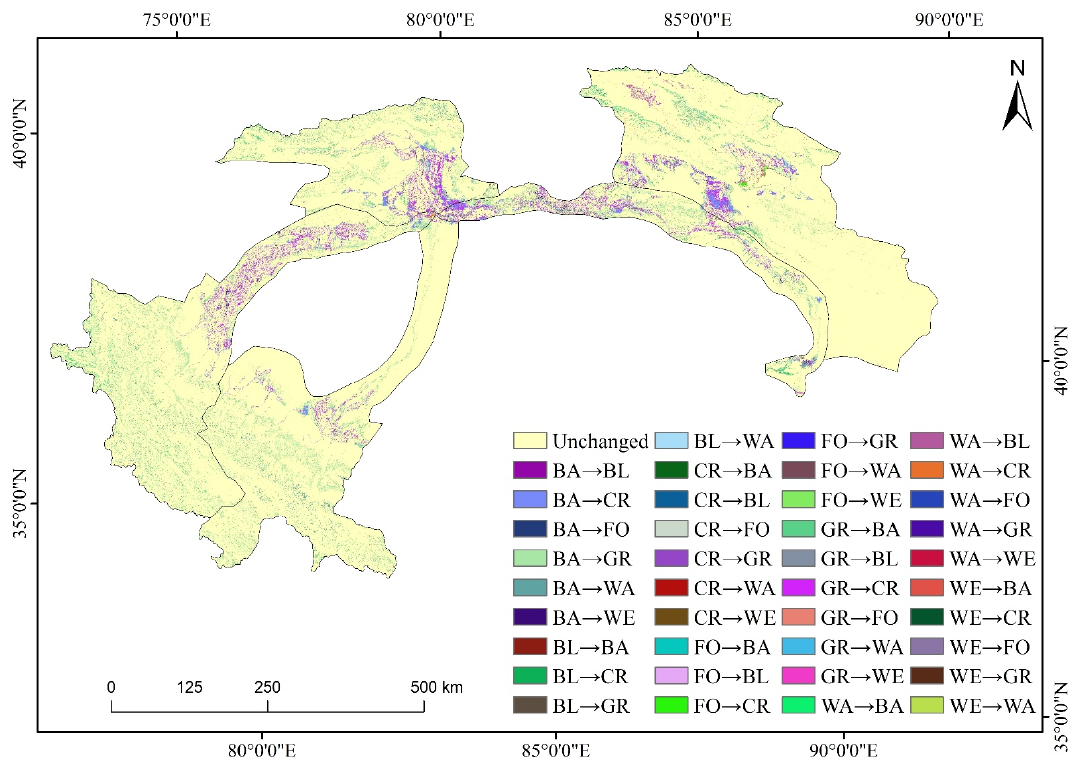
Figure 6. LUCC transfer in the TRB from 2000 to 2020 (CR: cropland; FO: forestland; GR: grassland; WA: water area; BA: barren; BL: construction land; WE: wetland).